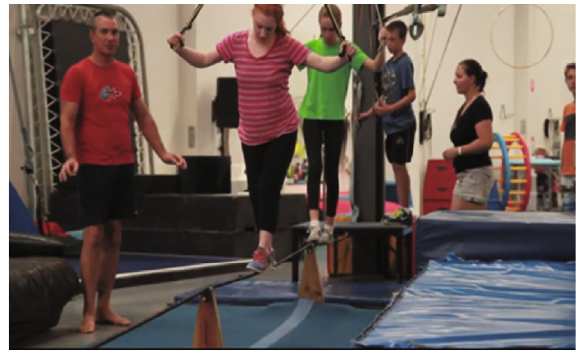
Figure 2: Social circus participants learn to tightrope walk